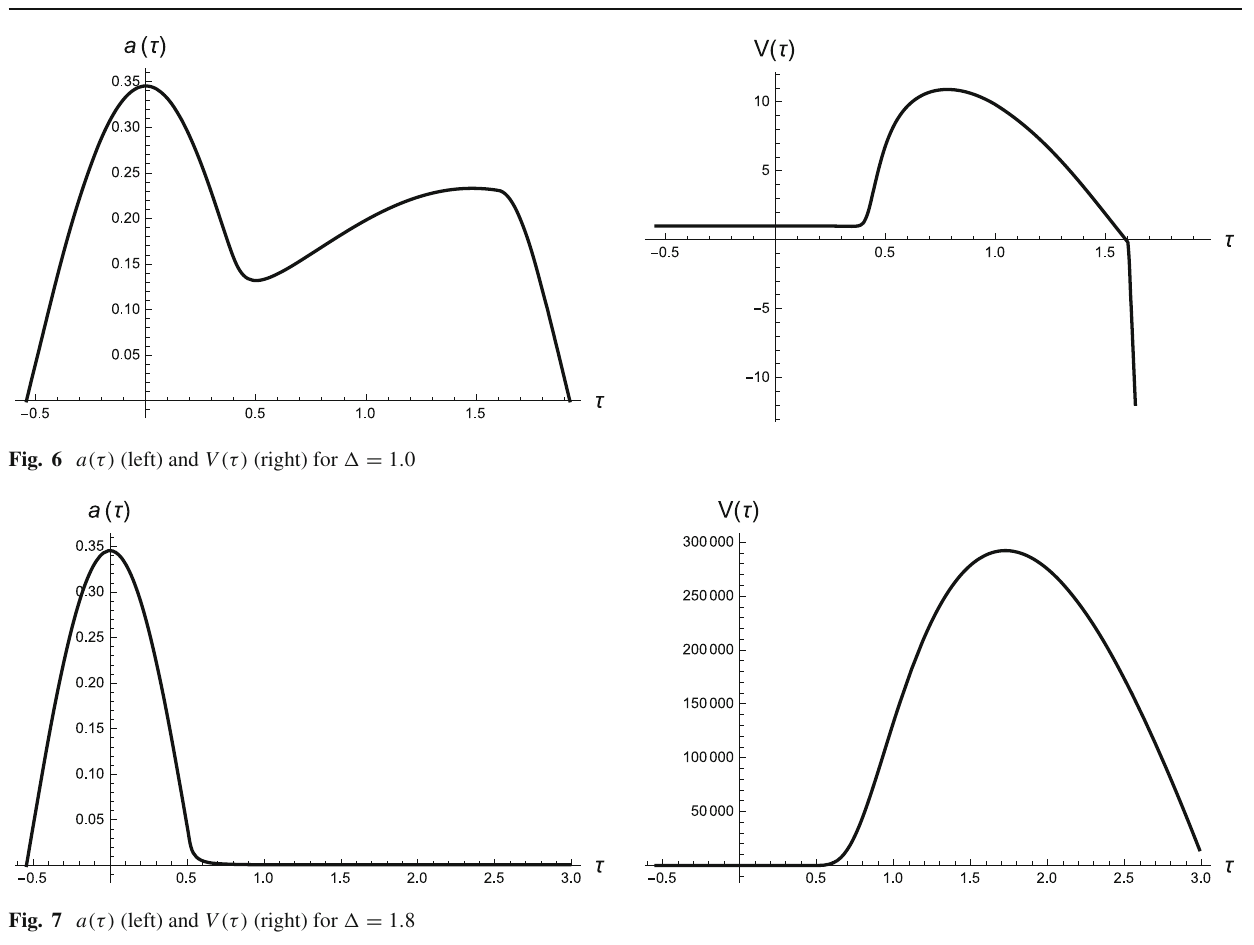
Fig. 7 a (τ) (left) and V (τ) (right) for (cid:19) = 1 .